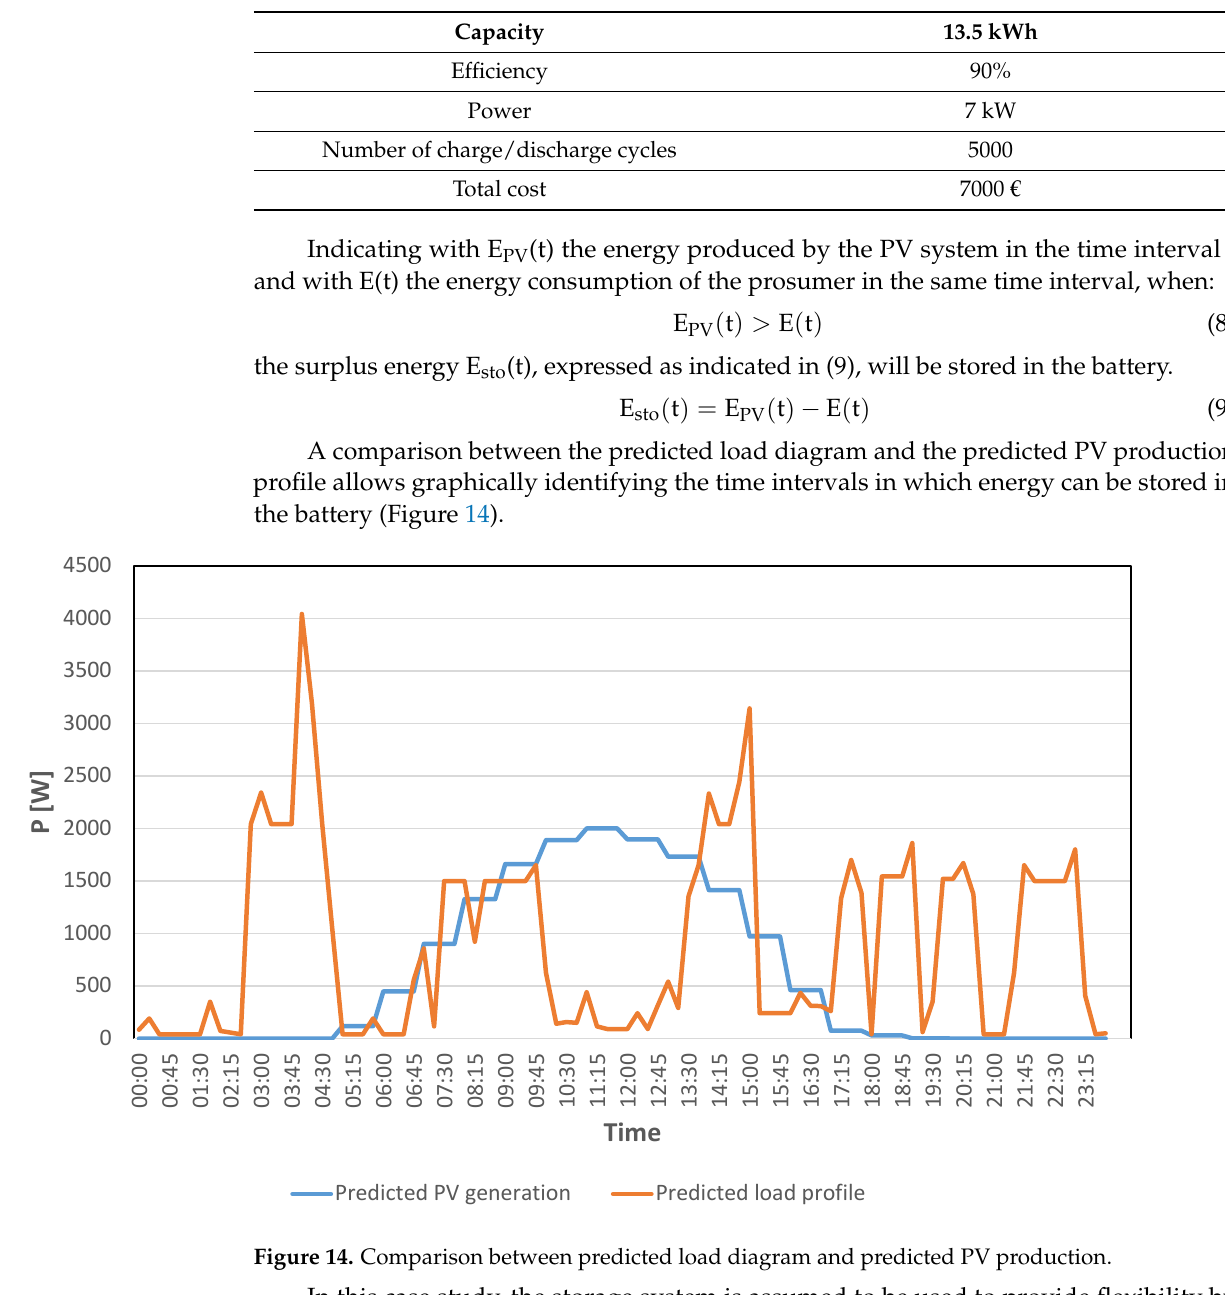
Table 4. Winner offer at 12:00. ΔP [W]